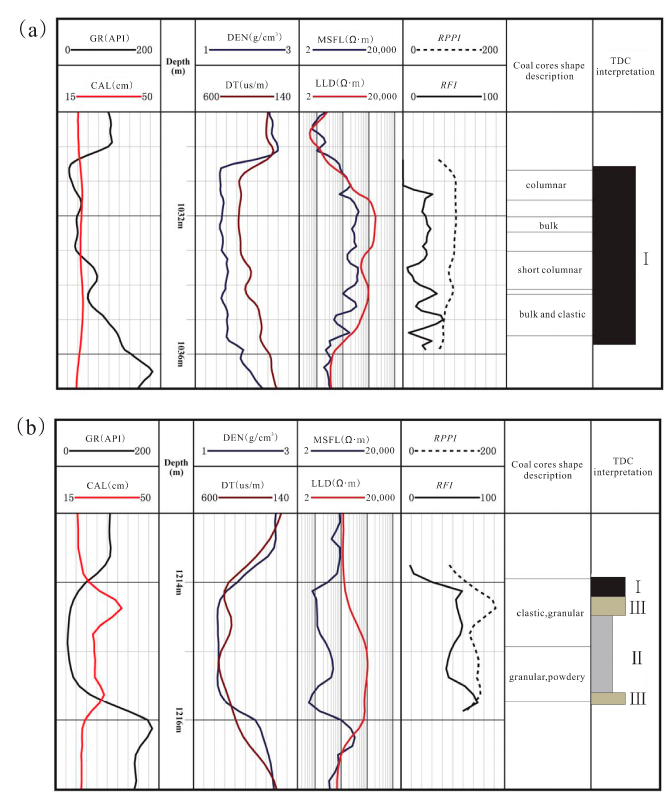
Figure 6. TDC results as interpreted from the core record corresponding to the dimensionless relative physical properties indicator ( RPPI ) and relative fluid properties indicator ( RFI ) of ( a ) the No. 11 coal seam of well LC04; ( b ) the No. 5 coal seam of well LC02.